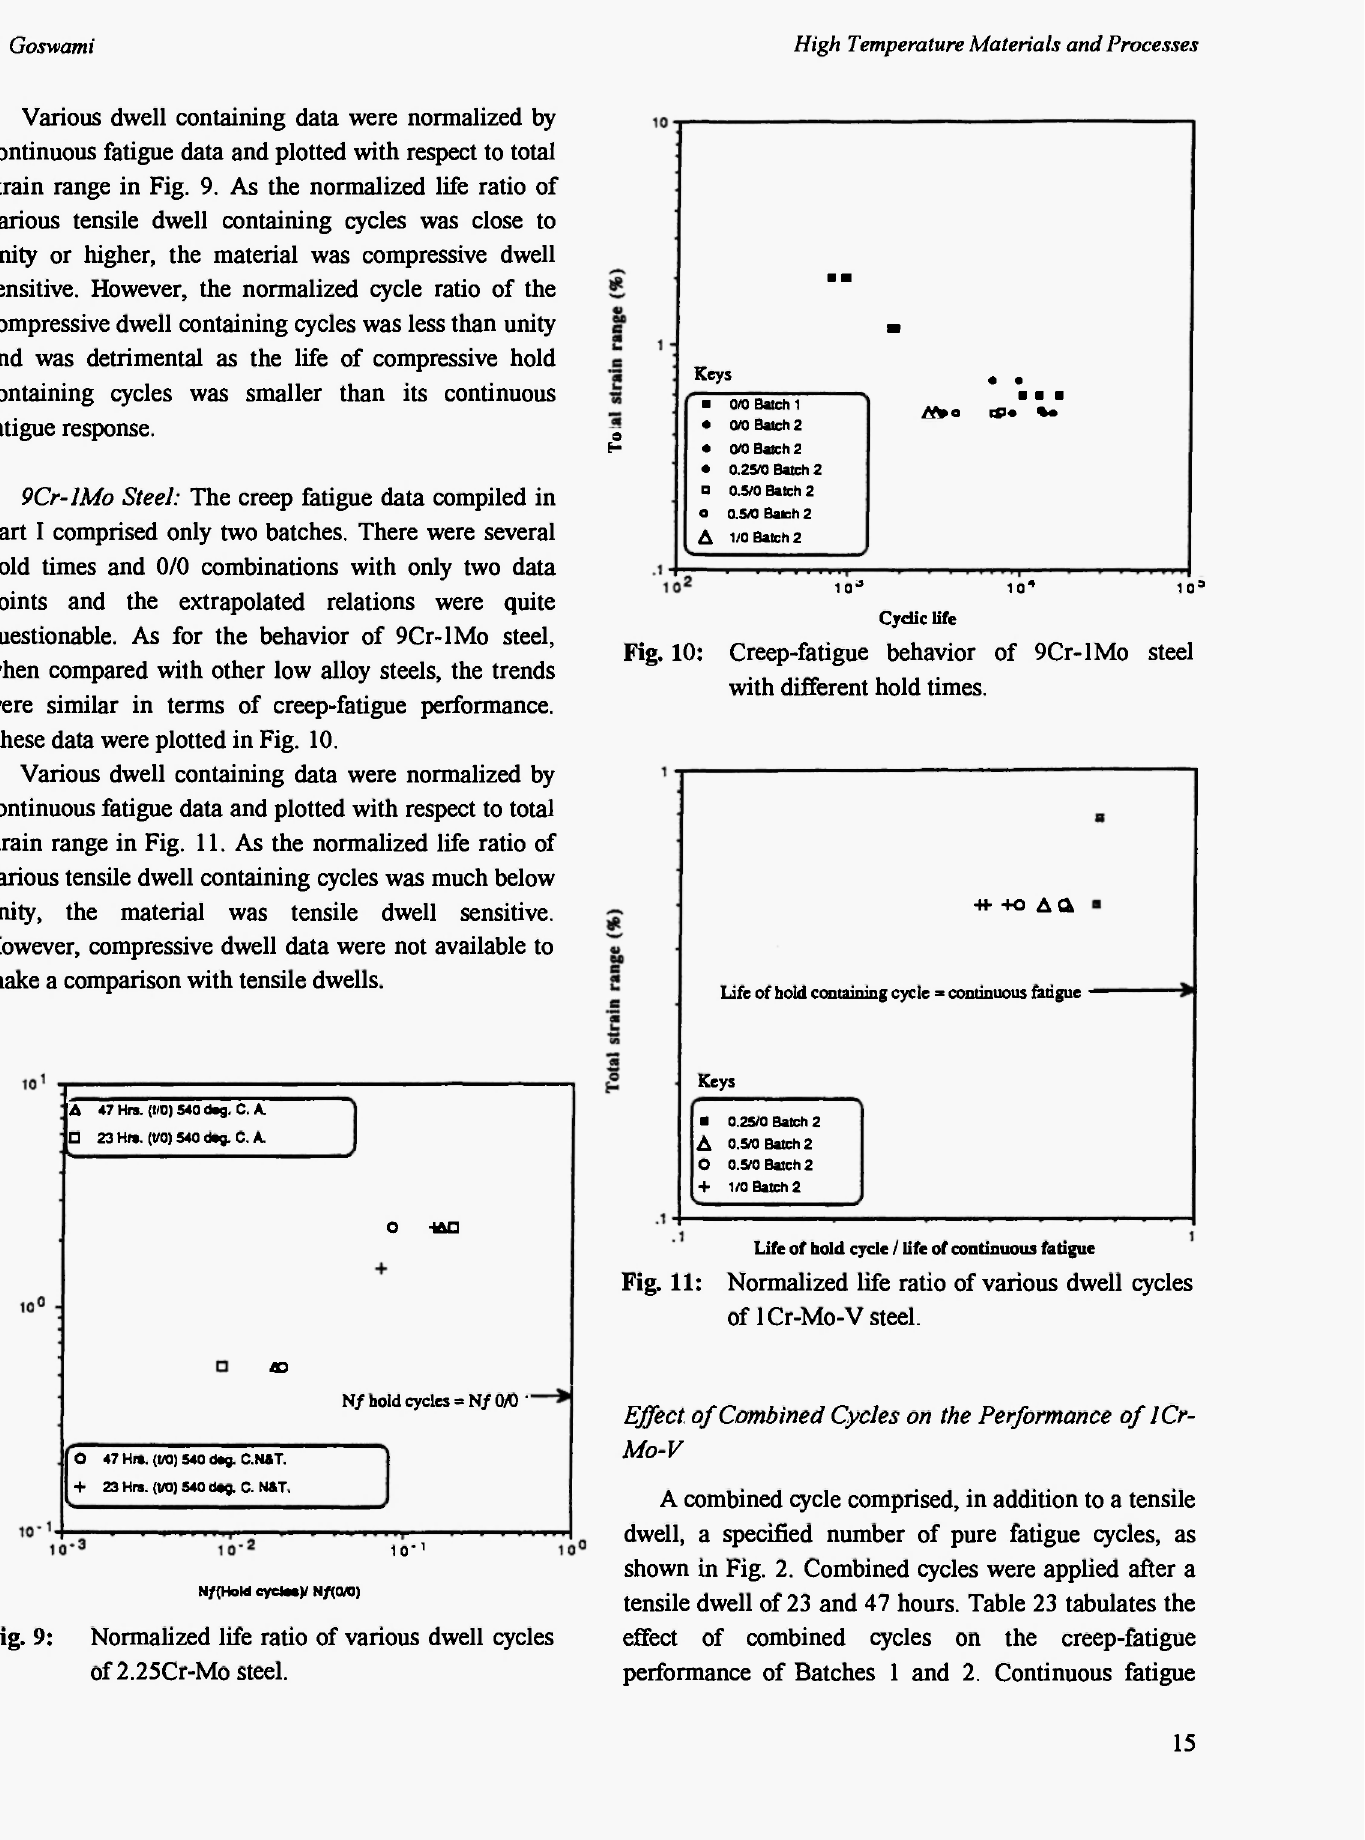
Fig. 9: Normalized life ratio of various dwell cycles of 2.25Cr-Mo steel.